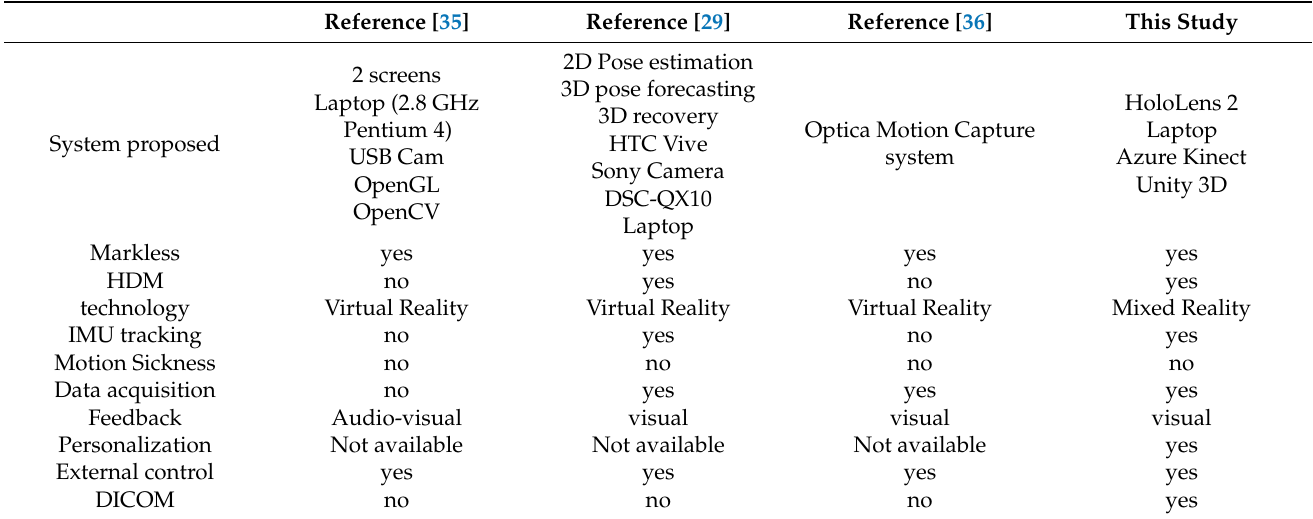
Table 4. Comparison of the systems used for supporting martial arts